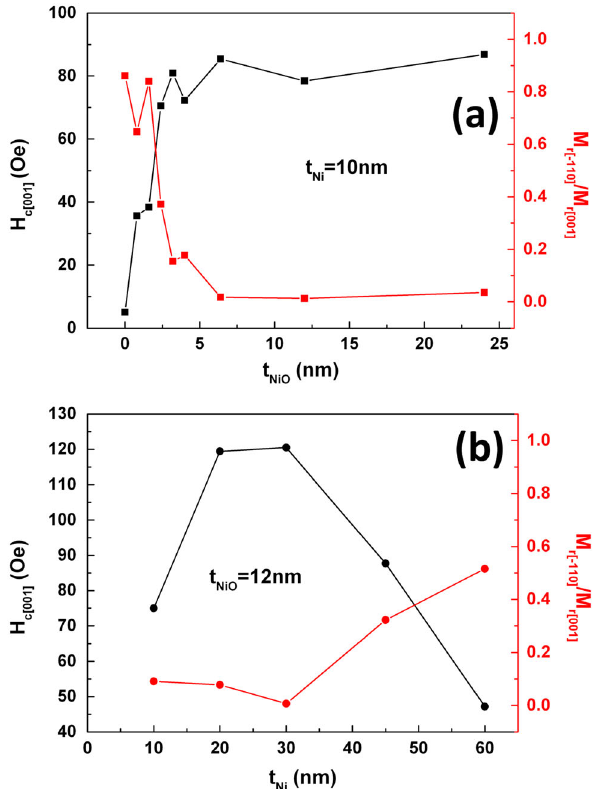
Fig. 3 Temperature dependence of the uniaxial anisotropy. a Temperature dependences of the magnetic moment and M r ratio of Ni(20 nm)/NiO(12 nm)/SrTiO 3 (110) heterostructure. b Easy and hard axis M-H curves of Ni(20 nm)/NiO(12 nm)/SrTiO 3 (110) hetero- structure measured at 560